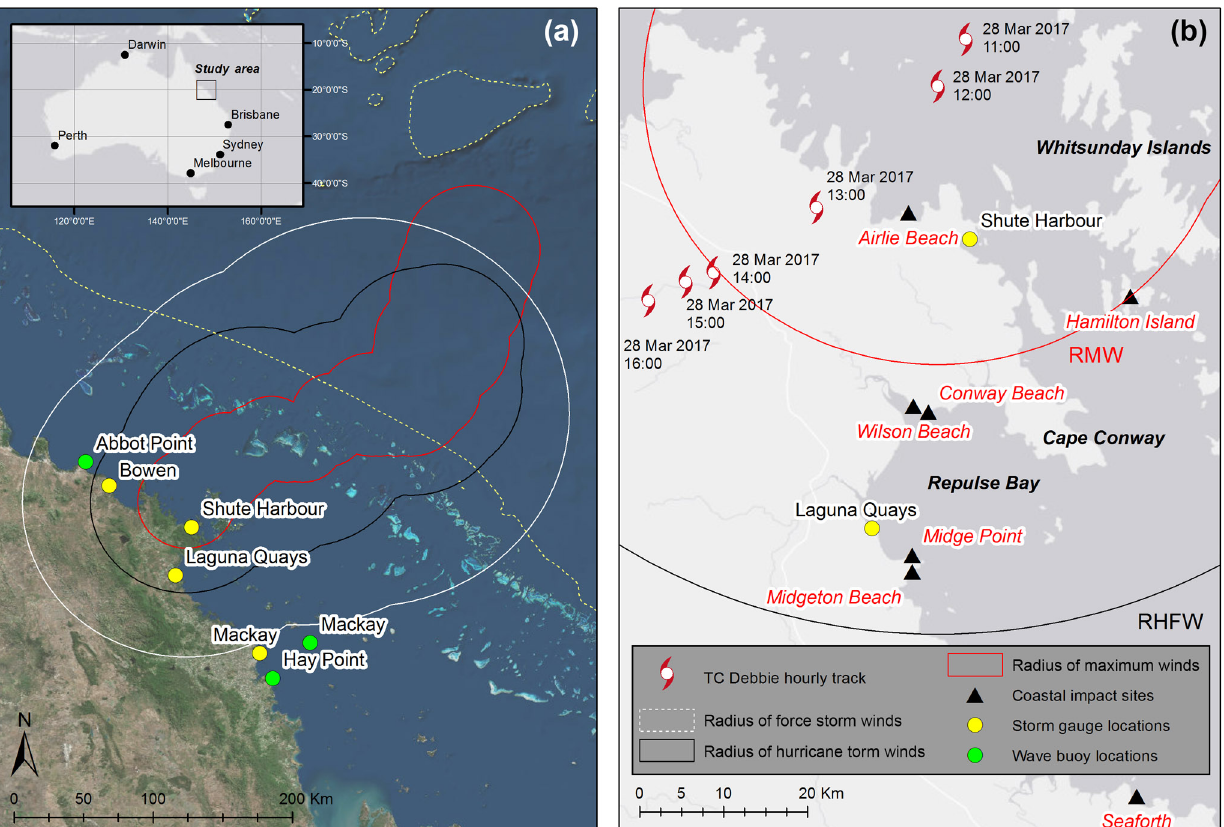
Figure 1. (a) Map of the study area, with regional inset, showing the Debbie best track between 00:00 27 March 2017 Australian Eastern Standard Time (AEST, UTC + 10h) and landfall (12:40 28 March) with radius of maximum winds (RWM, red), radius of hurricane-force winds (RHFW ( ≥ 33ms − 1 ), black) and radius of storm-force winds (RSFW ( ≥ 25ms − 1 ), white) (BoM, 2017). Locations of storm tide gauges (yellow dots) and wave buoys (green dots) used in this study are also shown. The 100m isobath, which approximates to the edge of the Great Barrier Reef shelf, is also shown (dotted yellow line, from Beaman, 2010). (b) also shows locations of study sites (black triangles) referred to in this